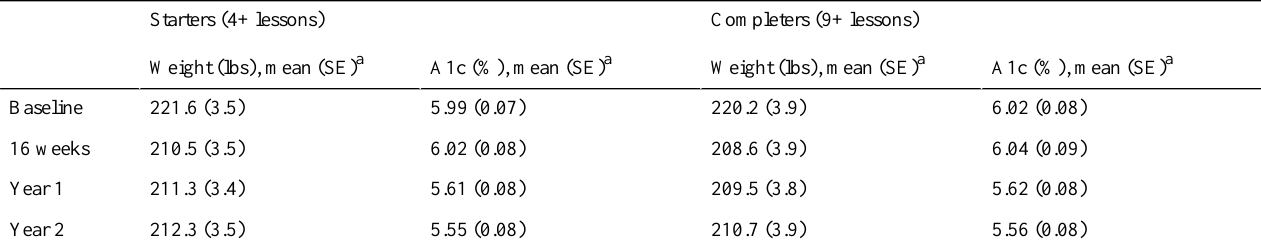
Table 2. Body weight and A1c of participants over time.